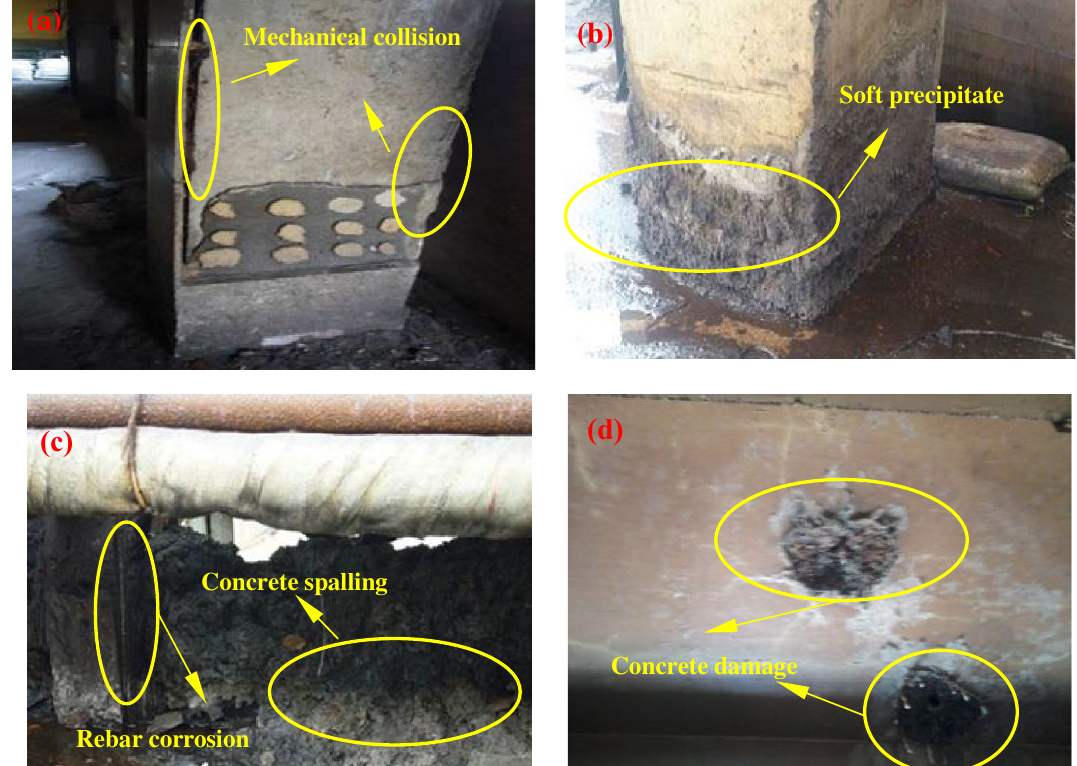
Figure 6. Appearance of concrete structure in the ammonium sulfate workshop. ( a ) The column in the warehouse; ( b ) the column in the synthesis section (outdoor); ( c ) the platform cornice in the vulcanization bed section; ( d ) the floor in the crystallization tank